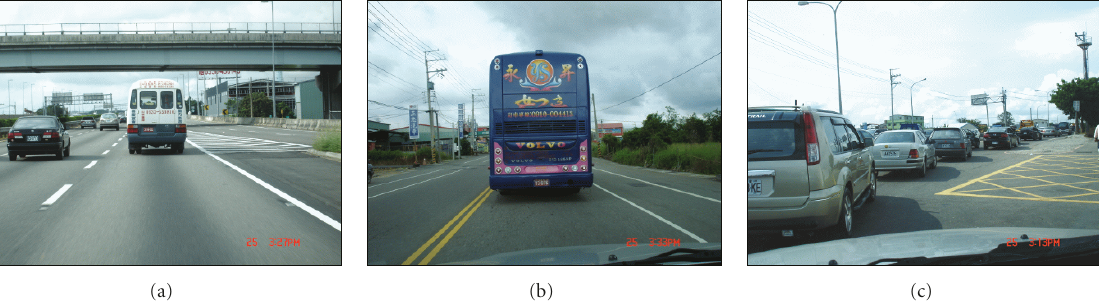
Figure 1: Example of two typical situations: (a) the front view is occluded on the high way; (b) the front view is occluded on the ordinary road; (c) a tra ffi c